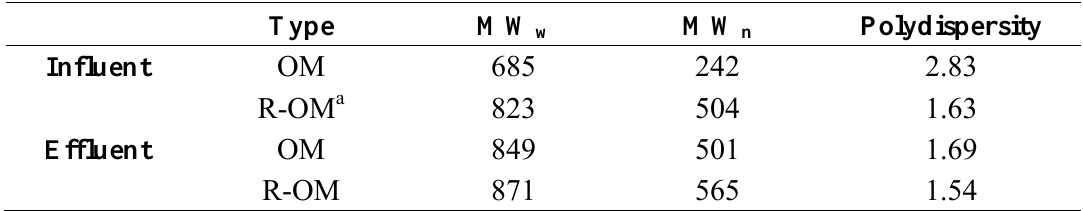
Table 3. Weight-average molecular weight (MW (MW ) and polydispersity for influent and effluent from the wastewater treatment plant n before and after 28-day